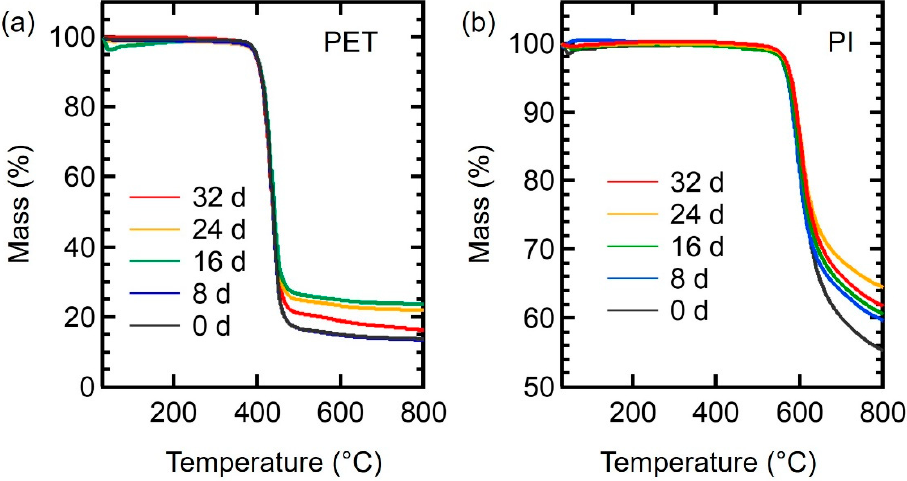
Figure 5. TGA curves of PET ( a ) and PI ( b ) films with various aging times.